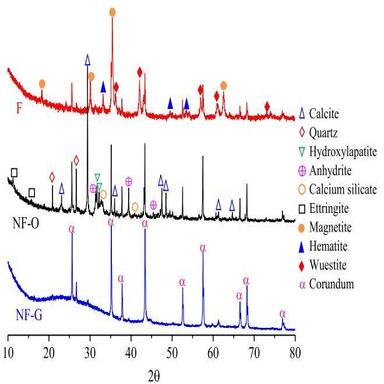
XRD spectrum of classified IBA for 1.18–6.3 mm particle size range.